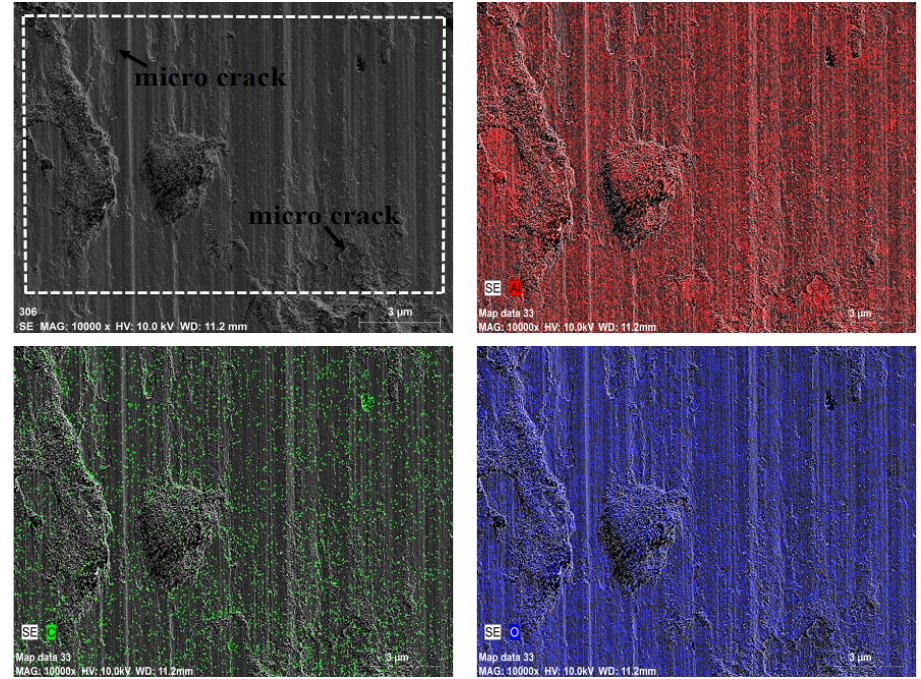
Figure 7: Worn surface EDS (Mapping) results under 30 N loads of 12% Al 2 O 3 reinforced composite